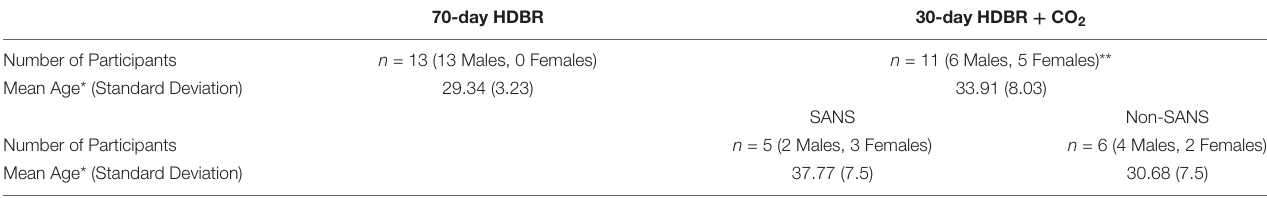
TABLE 1 | Subject demographic